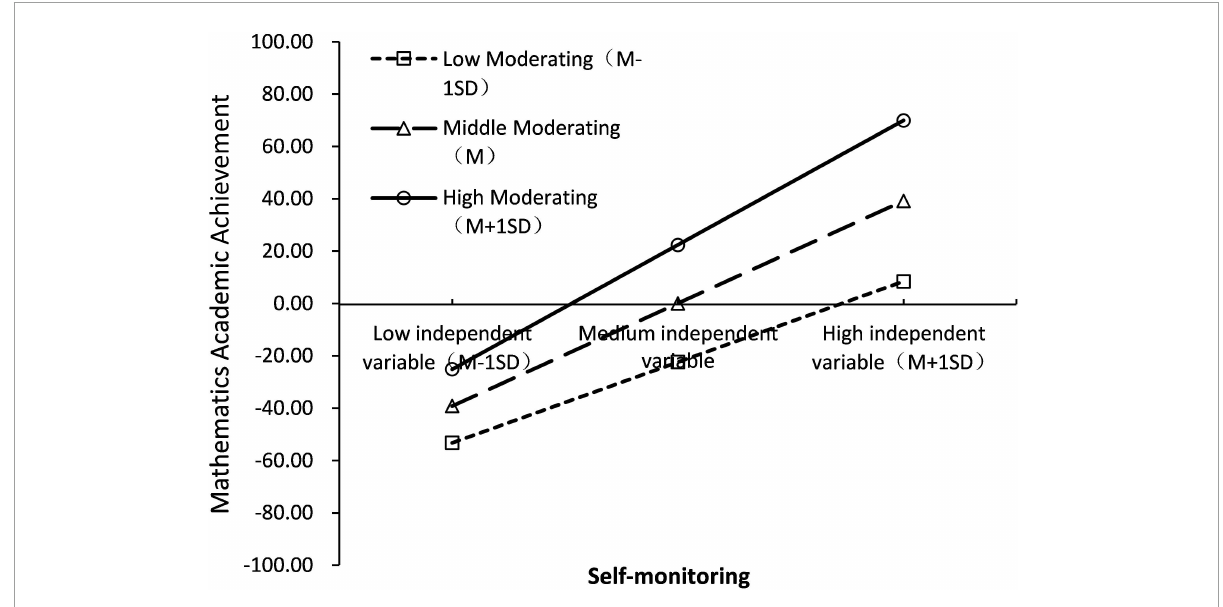
FIGURE5 Simple slope test (model